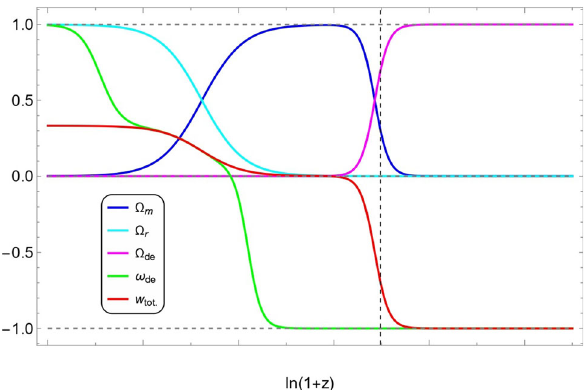
Fig. 4 The evolution of the density parameters ( (cid:15) de ), ( (cid:15) m ) and, ( (cid:15) r ) aswellasoftheequation-of-stateparameter,asfunctionsoftheredshift, λ = 0 . 001 with the initial conditions of dynamical system variables: x = 10 − 6 , y = 10 − 6 , u = 10 − 15 , ρ = 0 . 933234, z = 10 − 8 . The vertical dashed line denotes the present cosmological time ( z =